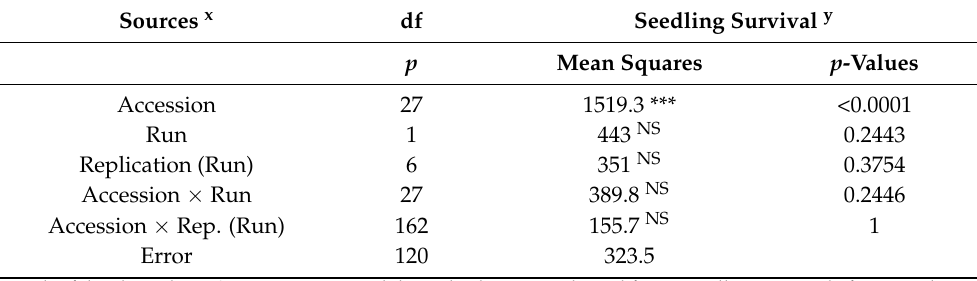
Table 2. Analysis of variance of percent survival of short-day USDA onion PI accessions and check seedlings at four weeks after inoculation with Fusarium oxysporum f. sp. cepae inside a growth chamber in two runs during